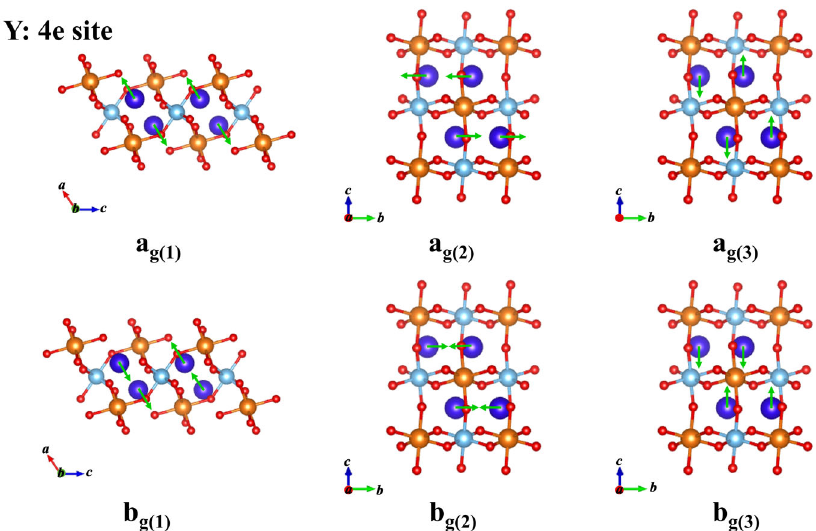
Fig. 22 Schematic representations of the vibrational modes of Y 2 MgTiO 6 system (Y at 4e site). Reproduced with permission from Ref. [504], © The American Ceramic Society 2019.